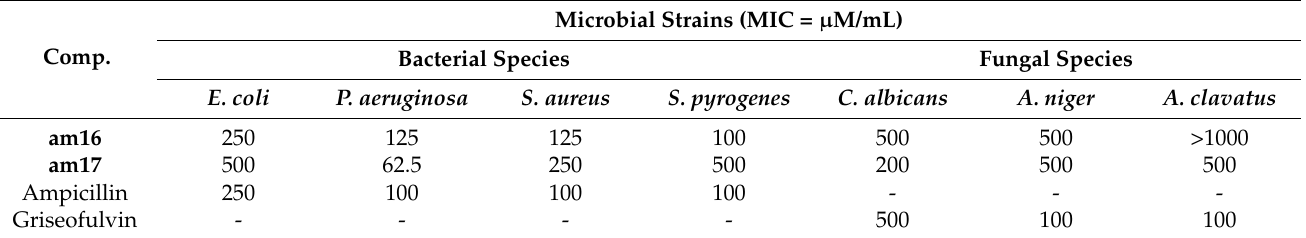
Table 9. Results of antimicrobial screening of the synthesized compounds ( am16 – am17 ).